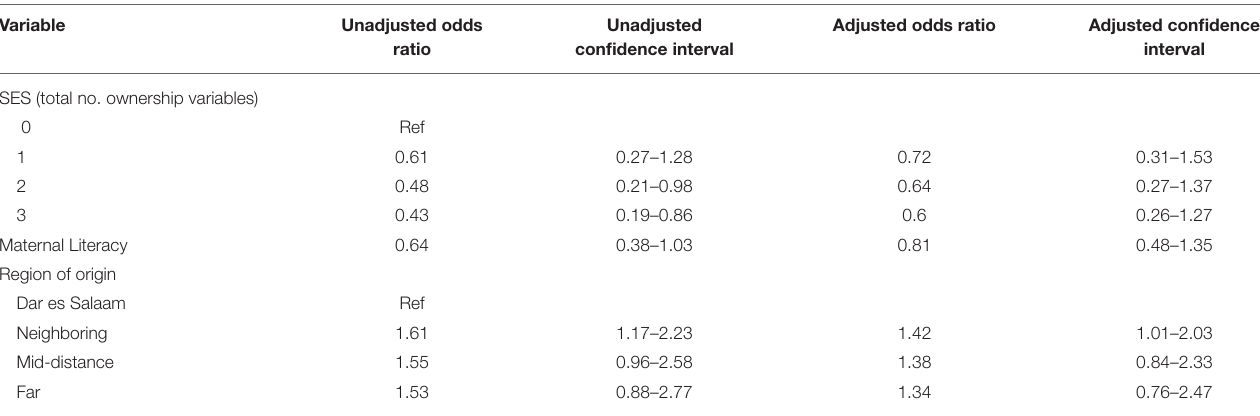
Unadjusted Adjusted odds ratio confidence interval